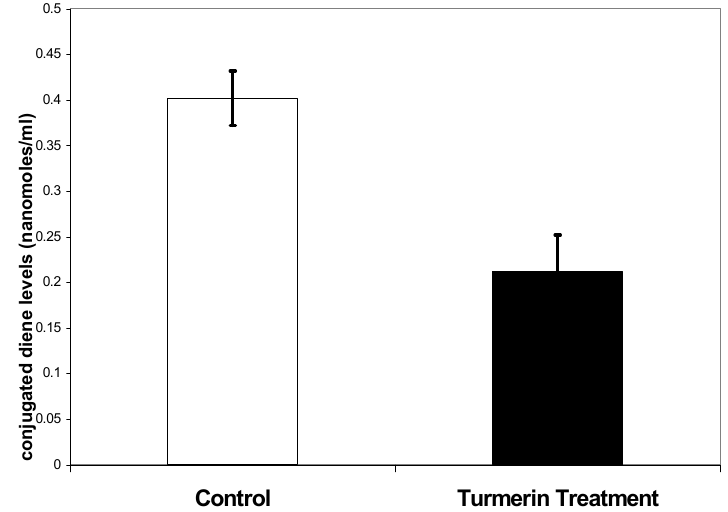
Figure 2. Lipid peroxidation as measured by MDA levels.